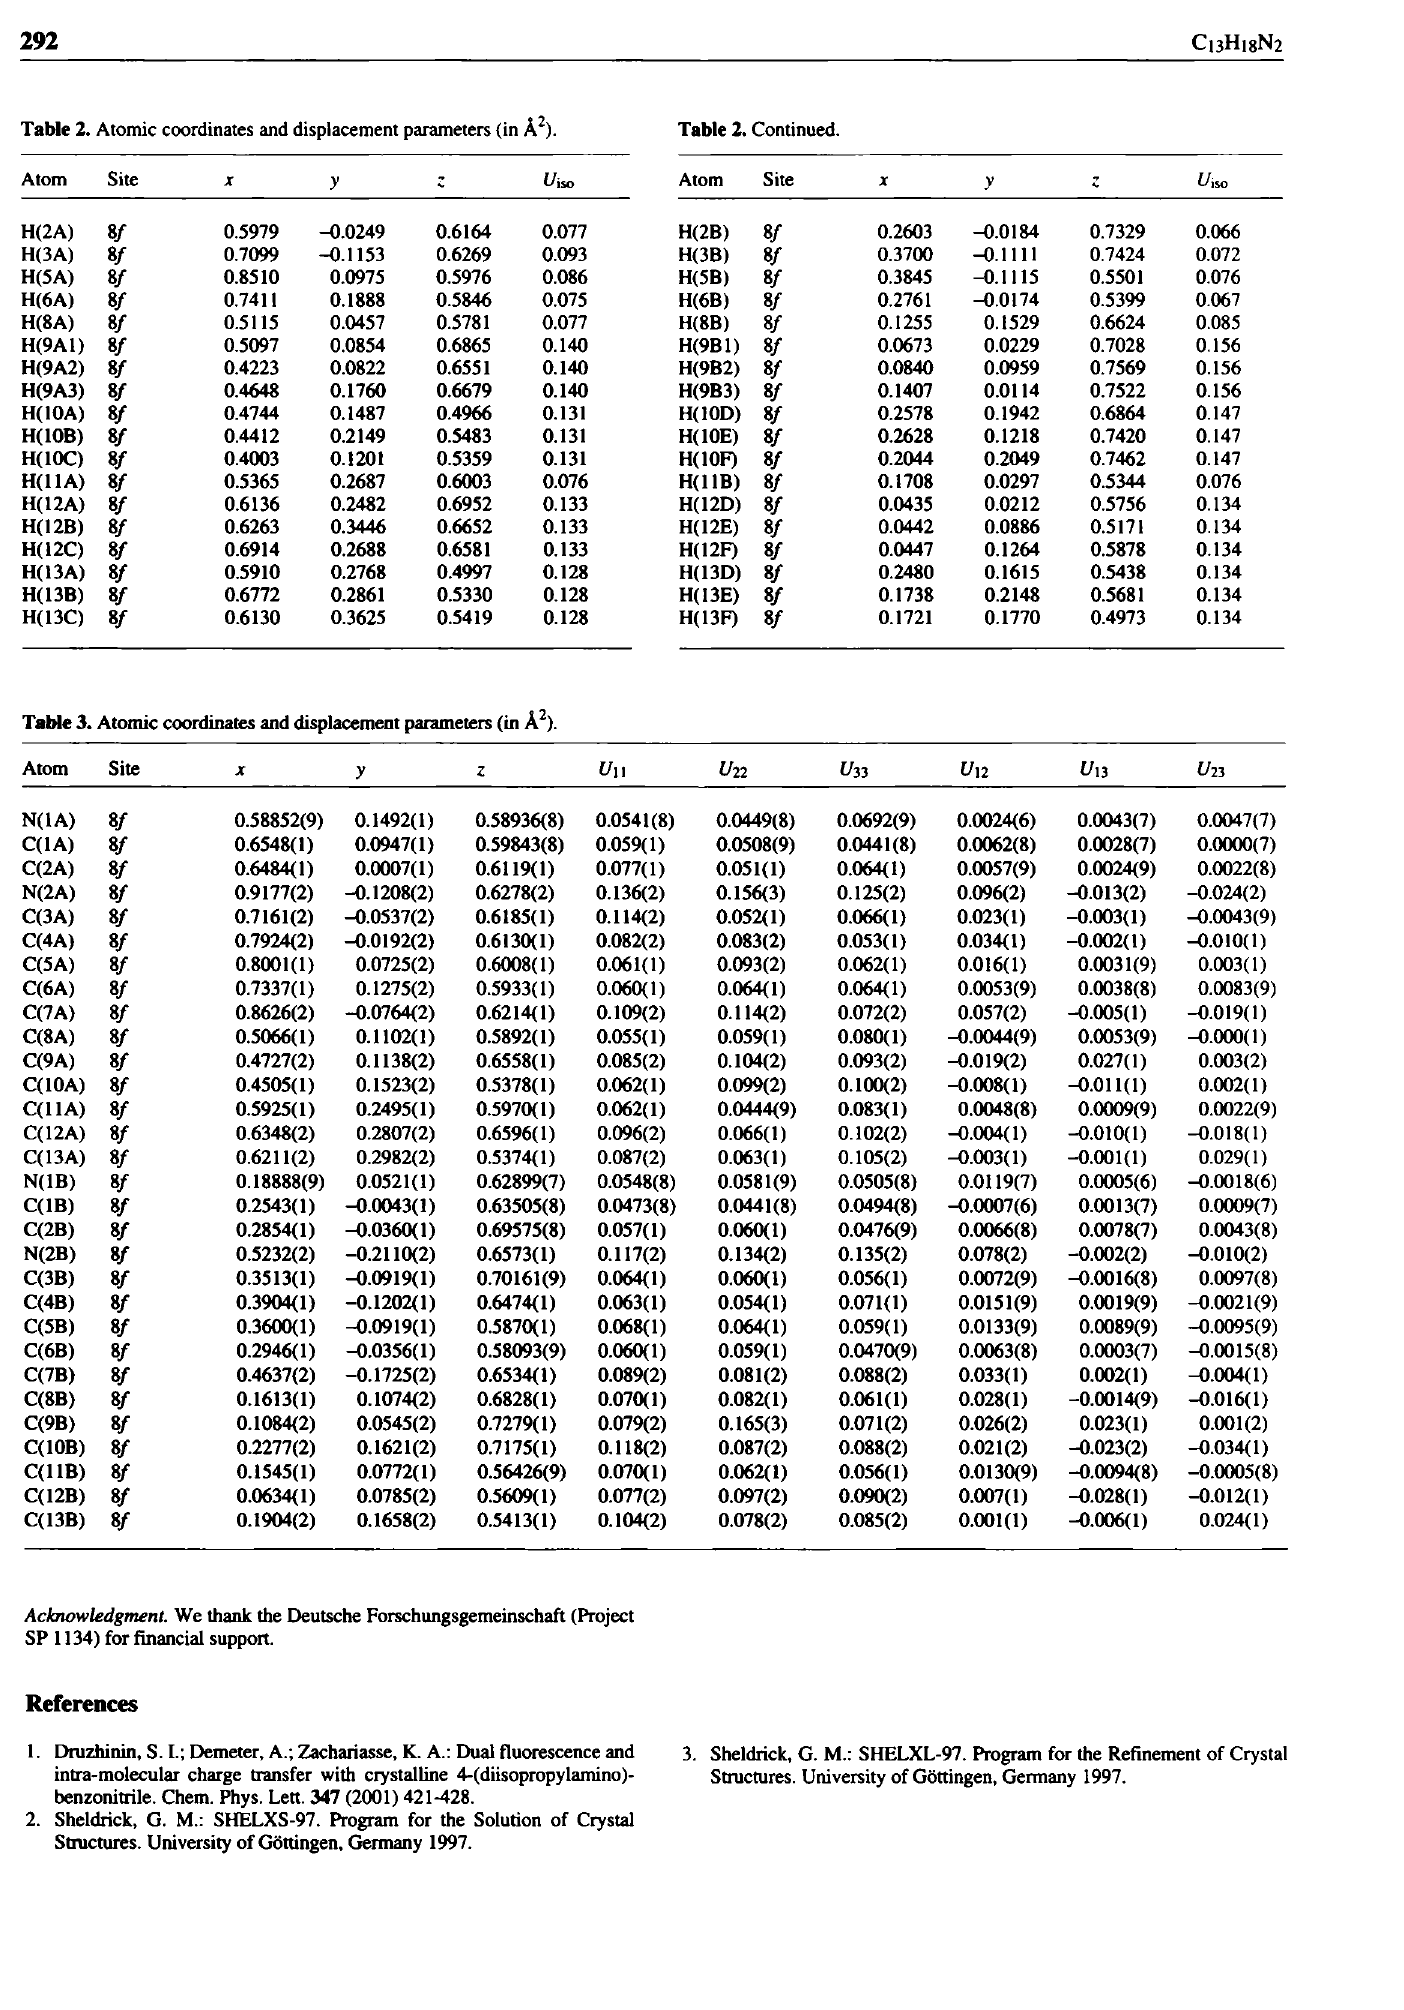
Table 2. Atomic coordinates and displacement parameters (in Â 2 ).